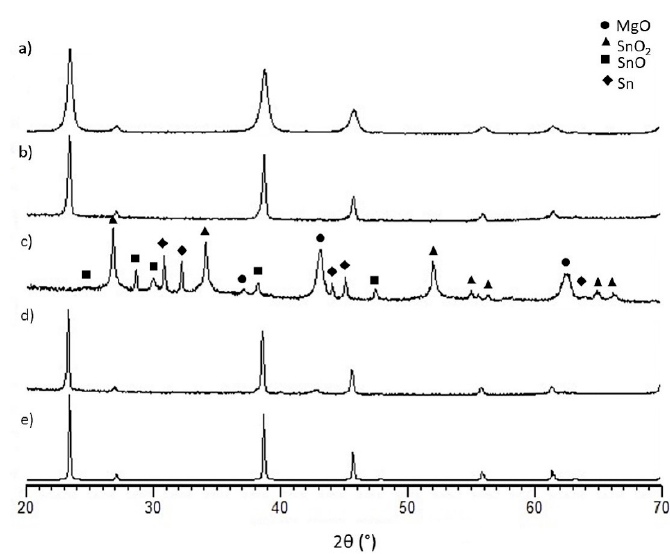
Figure 1. XRD spectra for a ) Mg-silicide powders b ) as sintered sample c ) aged Mg-silicide at 500 °C for 120 h without coating d ) aged Mg-silicide at 500 °C for 120 h with coating and c )PDF card of Mg 2 Si 0.4 Sn 0.6 (n. 01-089-4254).